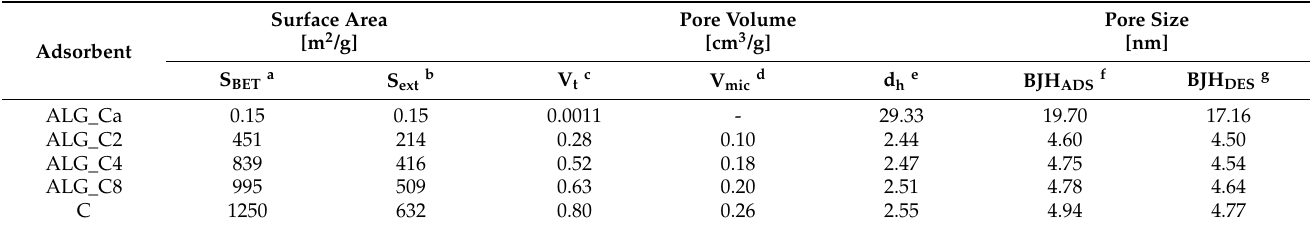
Figure 2. Nitrogen adsorption/desorption isotherms ( a ) pore size distributions calculated by using Barret, Joyner and Halenda (BJH) method using the adsorption ( b – d ) and desorption ( e – g ) data. Table 2. Textural parameters of the investigated calcium alginate, alginate-carbon composites, and active